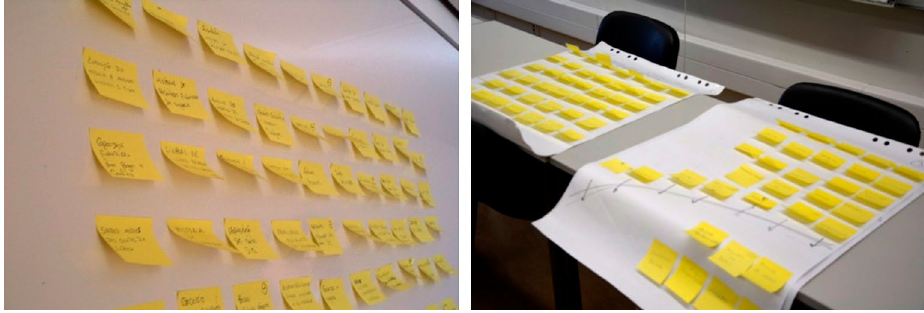
Figure 4. Snapshots of the “post-its